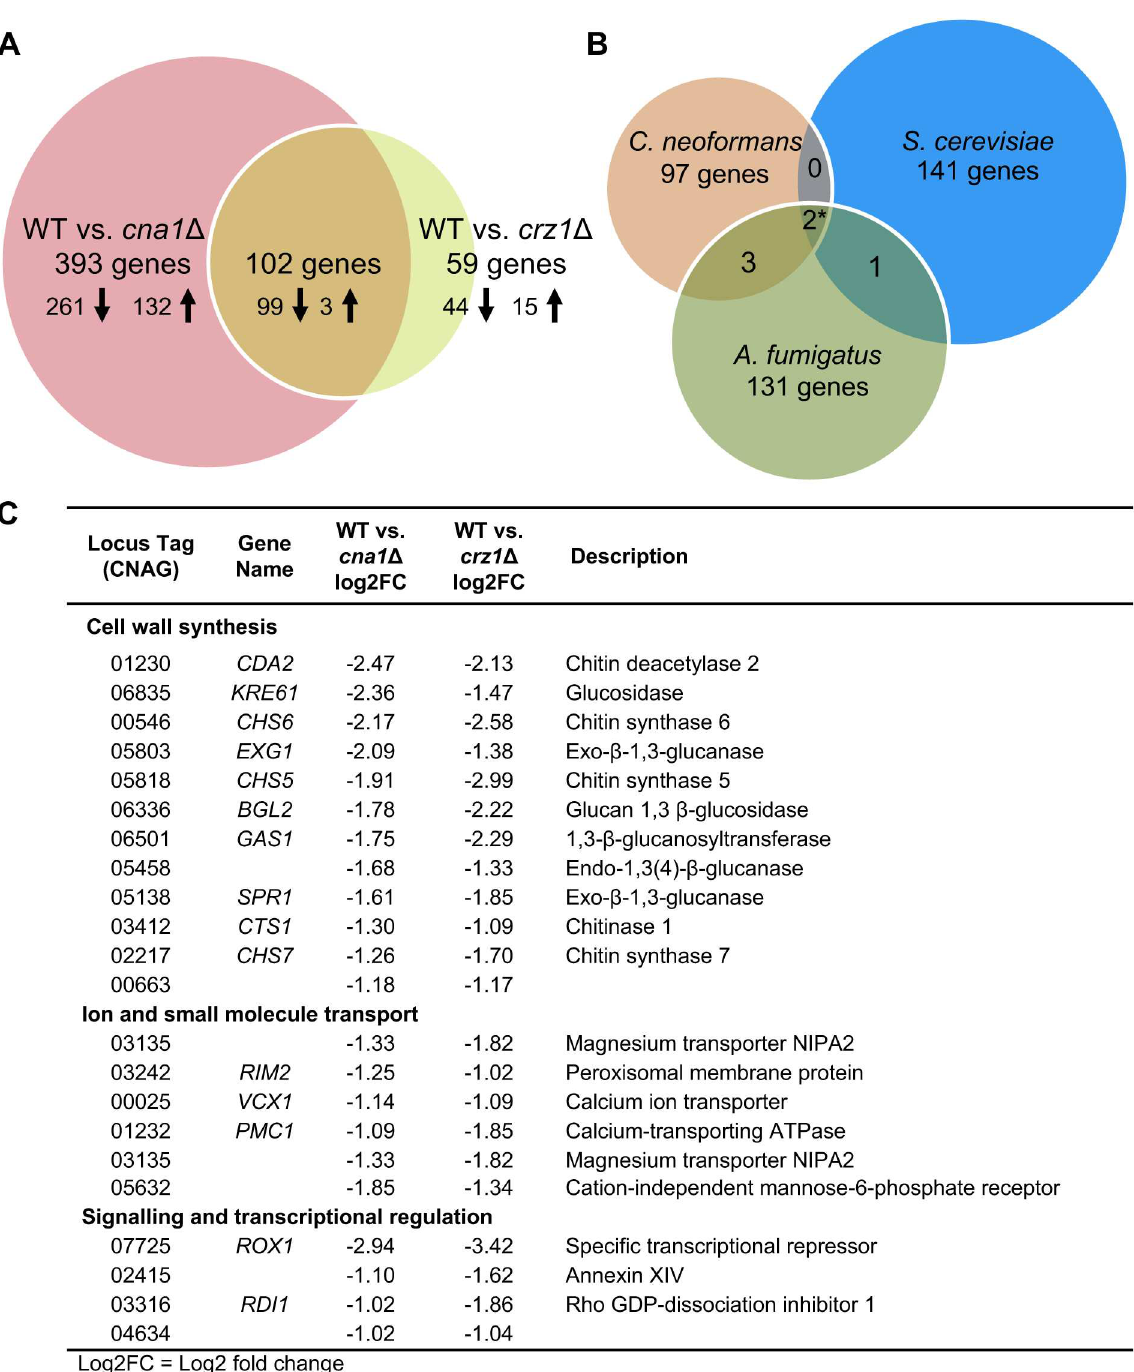
Fig 4. Gene suite regulated by the calcineurin-Crz1 pathway in C . neoformans . (A) Pairwiseanalysesof WT vs . cna1 Δ and WT vs . crz1 Δ gene sets were comparedto determine the regulatedgenes. 102 genes from both gene sets have differentialgene expressioncomparedwith the wild-typeat 37˚C and thus are controlledby both calcineurinand Crz1. 393 geneswere differentially regulatedby calcineurin, independently of Crz1, while 59 geneswere regulated by Crz1 in a calcineurin-independentmanner. (B) Comparisonof the 102 genes againstthe known S . cerevisiae (144 genes) and A . fumigatus (137 genes) gene sets revealedthat only two genes were shared in common betweenthe three species ( * Afu3g10690 and Afu7g01303 are both calcineurindependent homologs of CNAG_0123 and YGL006W –refer to S5 Table ). (C) Calcineurin-Crz1-dependentgenesof known functions. Gene names and descriptions listed were identifiedusing the FungiDBsearch portal; geneorthologywas determined using the GO function. (Log2FC= Log2 Fold